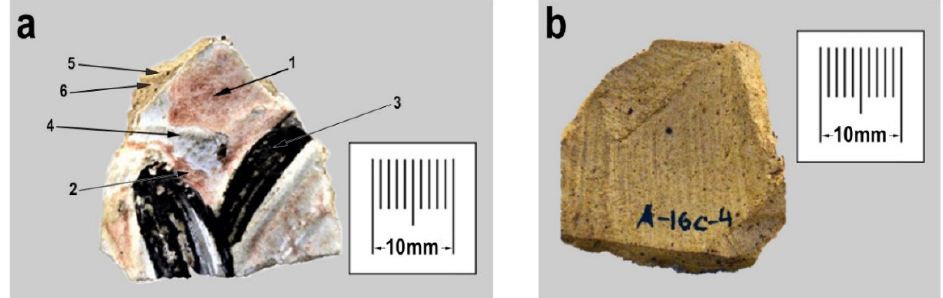
Figure 4. Polychrome figurine from Anan’evka walled settlement. Separate fragments. ( a )—outer surface, the arrows mark sites of SEM-EDS examination. 1—red glaze decoration, point 1; 2—red glaze decoration, point 2; 3—black glaze decoration, point 1; 4—white slip, point 1; 5—ceramics paste, point 1; and 6—ceramics paste, point 2. ( b )—inner surface with the imprints.